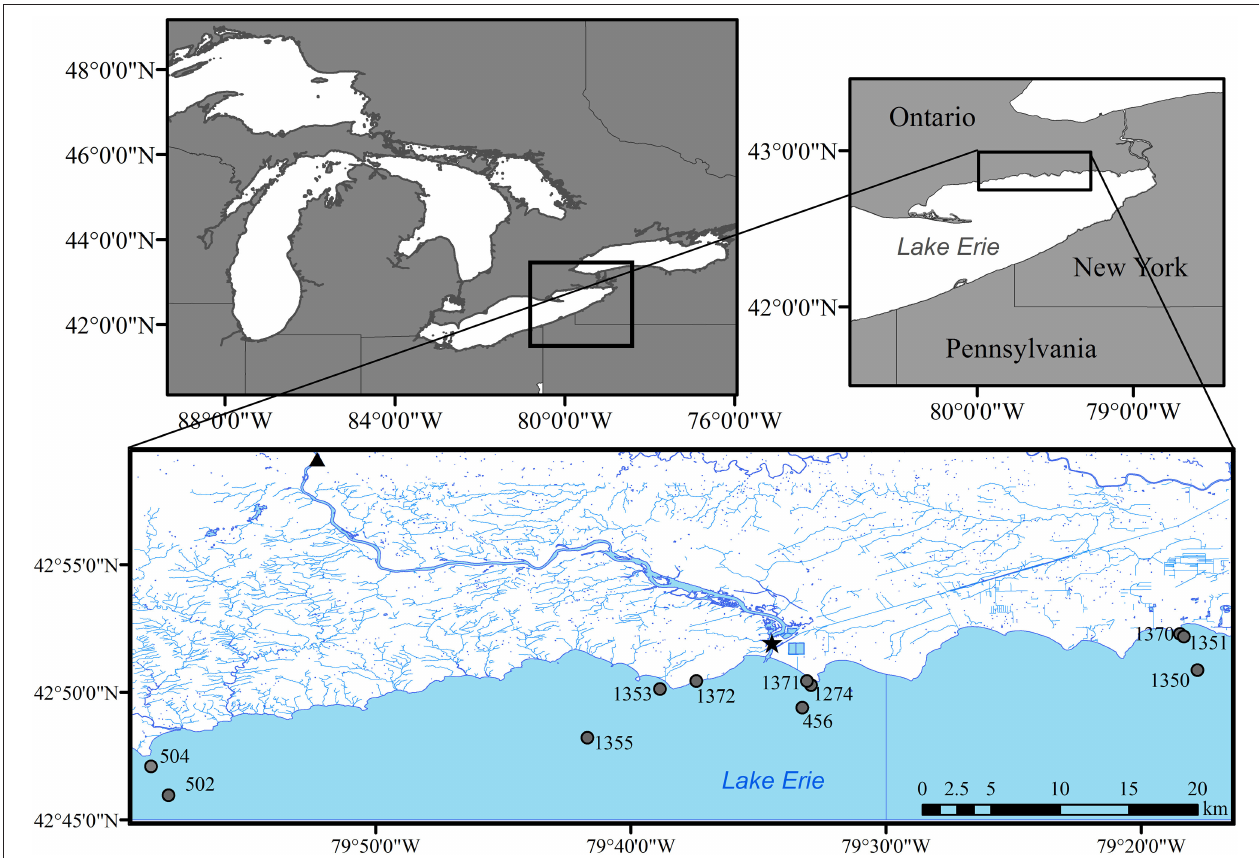
FIGURE 1 | Sampling sites in eastern Lake Erie during 2014, including lake stations (circles), river mouth (star), and long term nutrient loading station (triangle) for the Grand River at York,